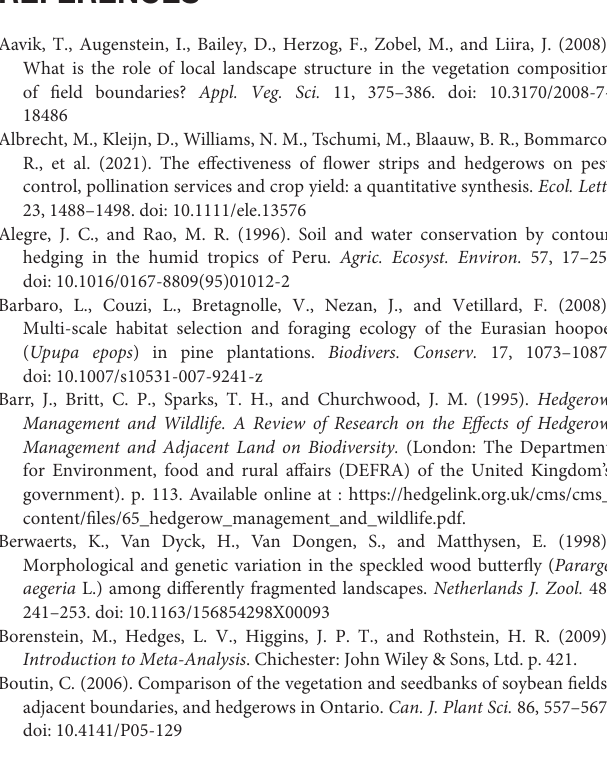
Figure 1 ; BioHEFA.docx contains the statistical analyses performed on Data File 2 ; BioHENH.docx contains the statistical analyses performed